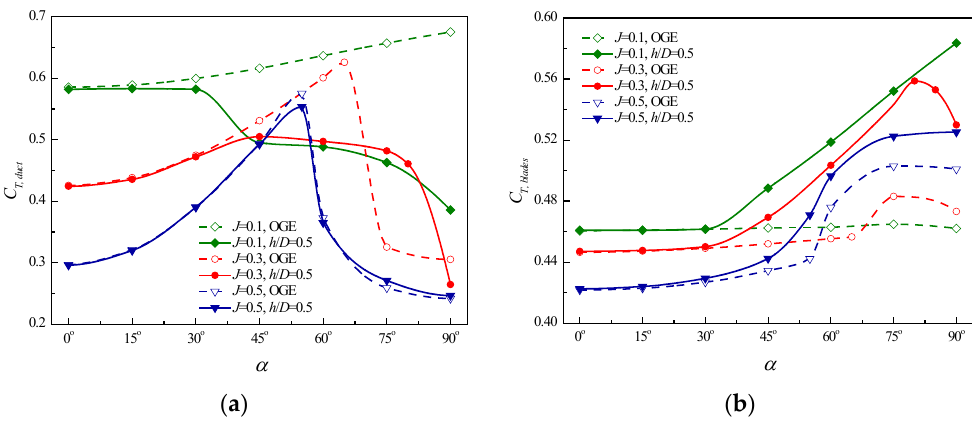
Figure 24. Division of thrust between the blades and the duct: ( a ) thrust coefficient of duct; ( b ) thrust coefficient of blades.